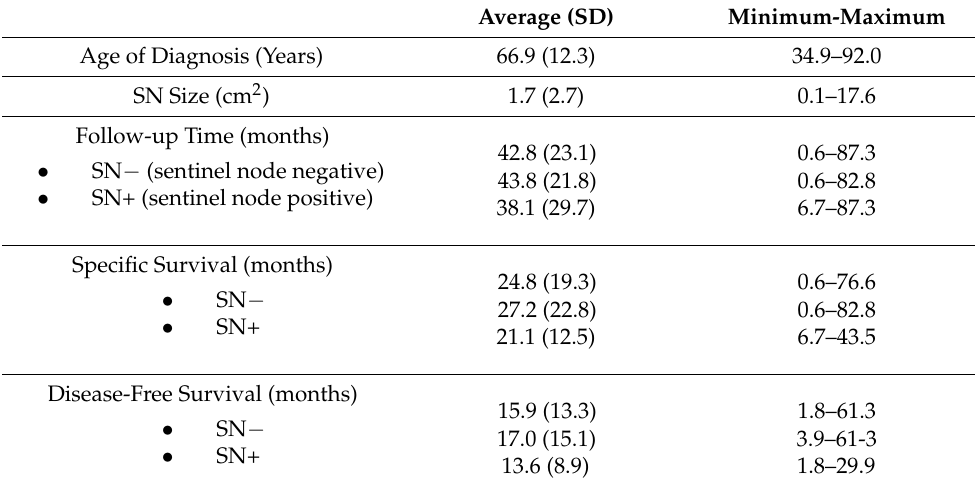
Table 2. Descriptive summary of the quantitative variables of the patients included in the